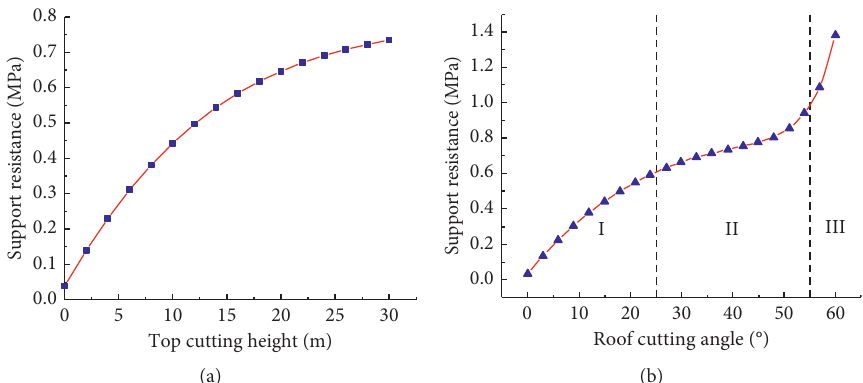
Figure 3: Distribution curve of roof support resistance under different roof cutting conditions. (a) Relationship between roof cutting height and support resistance. (b) Relationship between roof cutting angle and support